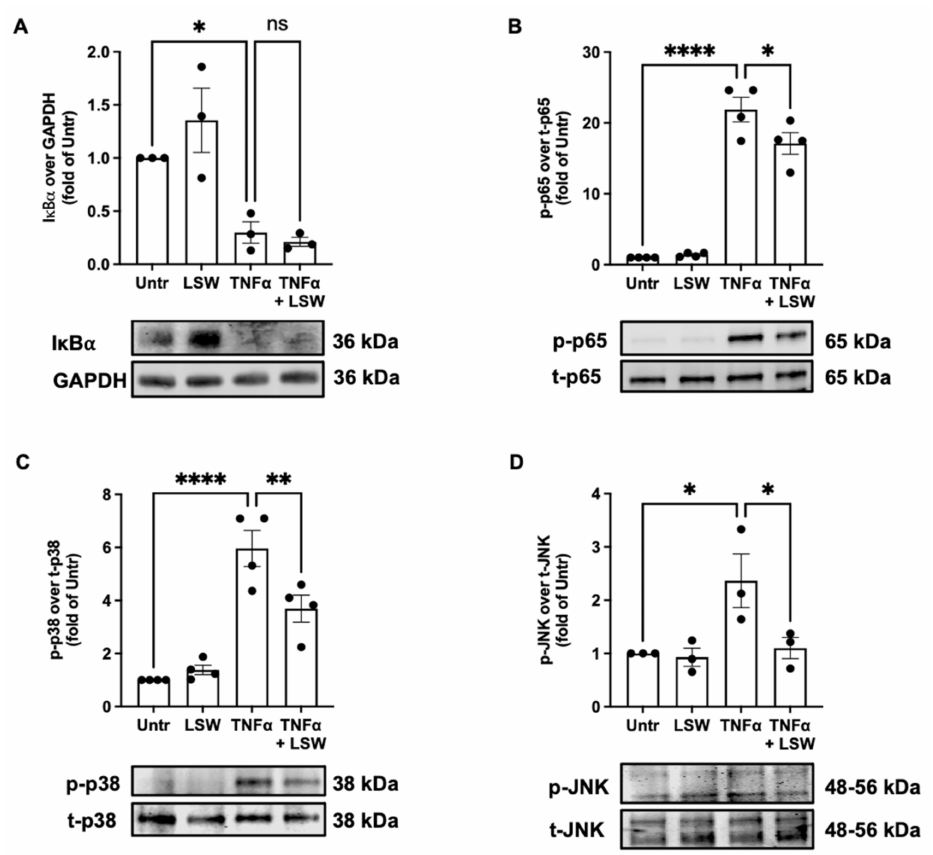
Figure 4. Effect of LSW treatment on TNF α -mediated NF- κ B and p38/JNK signaling in EA.hy926 cells. The cells were treated with LSW (50 µ M) for 18 h before TNF α (10 ng/mL) stim- ulation for 15 min, followed by the detecting the protein expression of I κ B α ( A ), p65 ( B ), p38 ( C ), and JNK ( D ) by Western blotting. Protein bands of I κ B α were normalized to GAPDH; bands of the phosphorylated p65, p38, and JNK were normalized to their total forms. Data were normalized to the untreated group (Untr). *, p < 0.05; **, p < 0.01; ****, p < 0.0001, ns, not